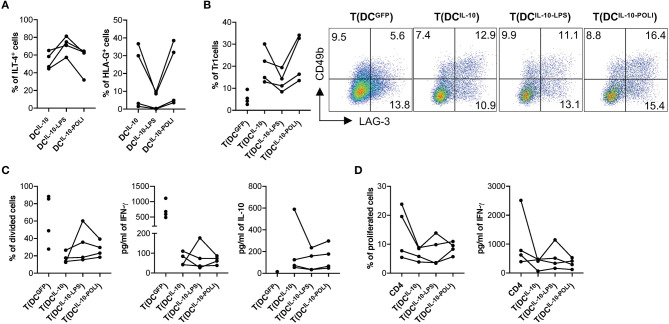
DCIL−10 are functionally stable cells. (A) At the end of differentiation, DCIL−10 were activated with LPS or Poli I:C for 24 h. HLA-G and ILT4 expression was assessed by flow cytometry. Each dot represents a single donor (n = 4). (B) On day 5 during DC differentiation, DCIL−10 were activate with LPS (DCIL−10−LPS), or Poli I:C (DCIL−10−POLI), or left unstimulated (DCIL−10). At the end of the differentiation, DC were used to stimulate allogeneic CD4+ T cells, cultured at 10:1 T:DC ratio. After 10 days, CD4+ T cultured with DCIL−10 [T(DCIL−10)], with DCIL−10−LPS [T(DCIL−10−LPS)], with DCIL−10−POLI [T(DCIL−10−POLI)], or with DCGFP [T(DCGFP)] were collected and the frequency of CD49b+LAG-3+ Tr1 cells was evaluated (n = 4) by flow cytometry. Each dot represents a single donor. Dot plots from one representative donor are shown and percentages of positive cells are indicated (right panel). (C) After culture, T(DCIL−10), T(DCIL−10−LPS), T(DCIL−10−POLI), and T(DCGFP) were purified by positive selection and stained with proliferation dye prior to re-stimulation with mDC, differentiated from the same donor used in primary stimulation. After 3 days, proliferation was evaluated by flow cytometry and the percentage of proliferated cells in the precursor population was calculated (left panel). IFN-γ and IL-10 production in culture supernatants was evaluated by ELISA (central and right panels, respectively). Each dot represents a single donor (n = 4). (D) CD4+ T cells were stained with proliferation dye prior to stimulation with mDC, differentiated from the same donor used in primary stimulation, in presence or absence of autologous T(DCIL−10), or T(DCIL−10−LPS), or T(DCIL−10−POLI) cells at 1:1 ratio. Percentage of proliferated cells at the end of the culture (left) was calculated by overall proliferation dye dilution. IFN-γ production in cell culture supernatants (right panel) was evaluated by ELISA. Each dot represents a single donor (n = 4).